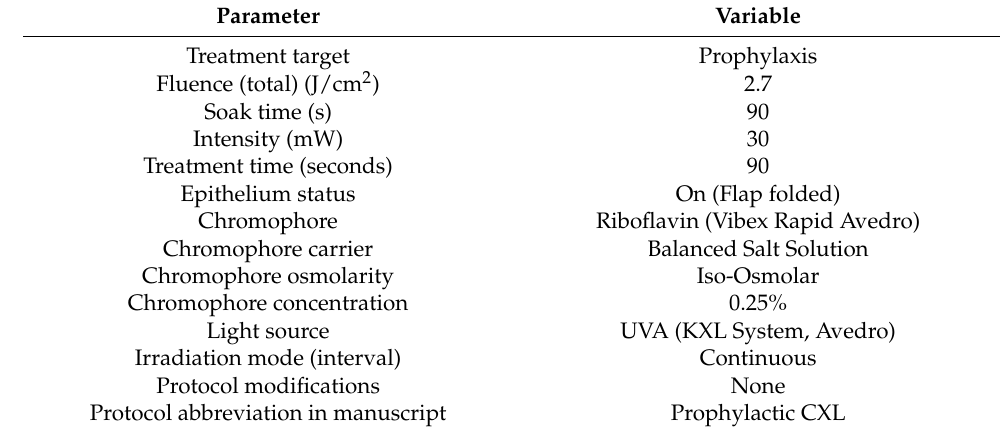
Table 1. Prophylactic cross-linking